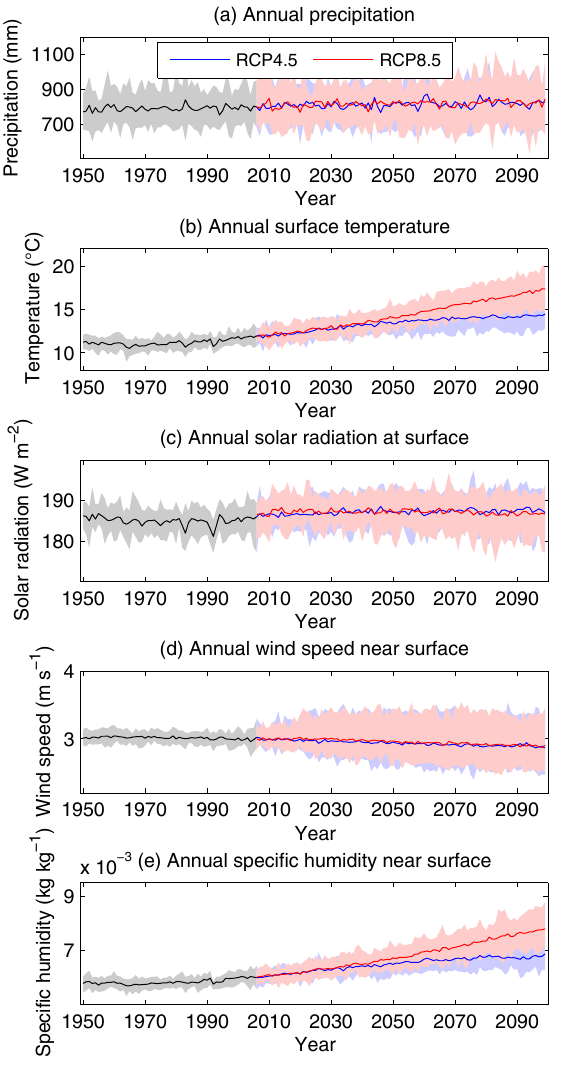
Figure 3. Temporal variations of annual mean precipitation (a) , sur- face air temperature (b) , solar radiation at surface (c) , wind speed near surface (d) , and specific humidity near surface (e) over the CONUS. Thick lines and the shading denote the multi-model en- semble means and uncertainty ranges of the 20 GCMs,